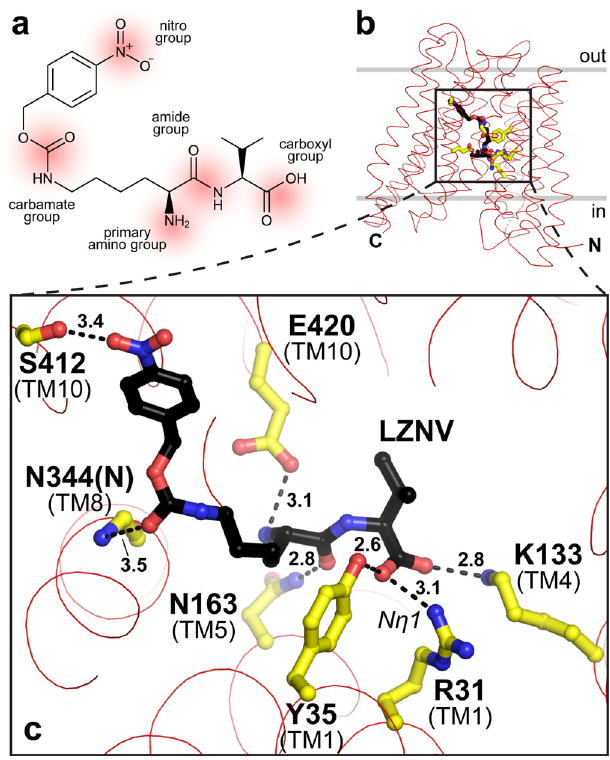
Fig. 3 LZNV binding pocket in YePEPT K314A and molecular protein-ligand interactions. a Chemical structure of LZNV. Polar and ionic groups are labelled and highlighted in red. b Overall structure of YePEPT K314A with bound LZNV oriented in the lipid membrane according to the PPM- server 70 . The location of the binding pocket in the transporter is indicated by a black box. c Detailed view into the LZNV binding pocket. Polar and ionic interactions of LZNV (black sticks) with amino acid residues (yellow sticks) located in the binding pocket of YePEPT K314A are displayed. All polar and ionic interactions within a distance ≤ 3.5 Å from amino acid residues to the ligand are shown as dashed lines (distances in Å). Amino acids are labelled in the one-letter code and corresponding TMs are indicated in brackets. For N344, the interaction with the main-chain nitrogen is indicated by